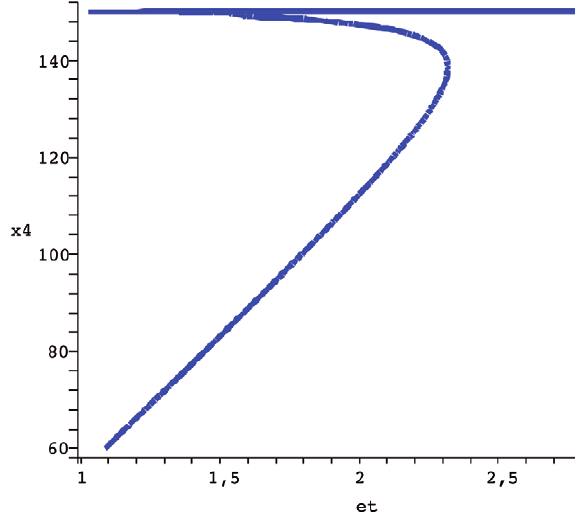
Figure 5. Bifurcation diagram X 4 vs et. The parameters used are k 1 ~ 62846 : 678, k 2 ~ 0 : 70598597, k 3 ~ 1223 : 6617, k 4 ~ 12 : 903767, k 5 ~ 603 : 65743, k 6 ~ 29514 : 848, k 7 ~ 119 : 08971, k 8 ~ 1225 : 0265, k 9 ~ r 4048 : 1216, k 10 ~ 1, k 11 ~ 1, k 12 ~ 1, k 13 ~ 150 : 08654, k 14 ~ 8 : 6541 : 10 { 2 .